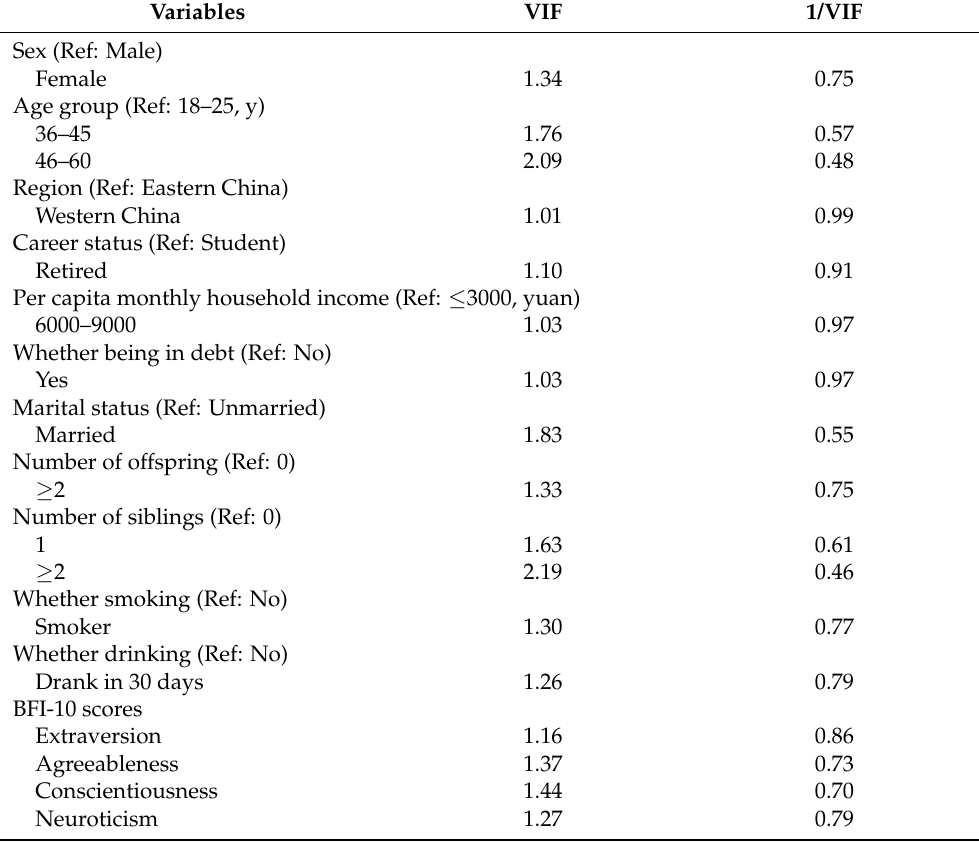
Table A3. The variance inflation factor of variables in stepwise regression